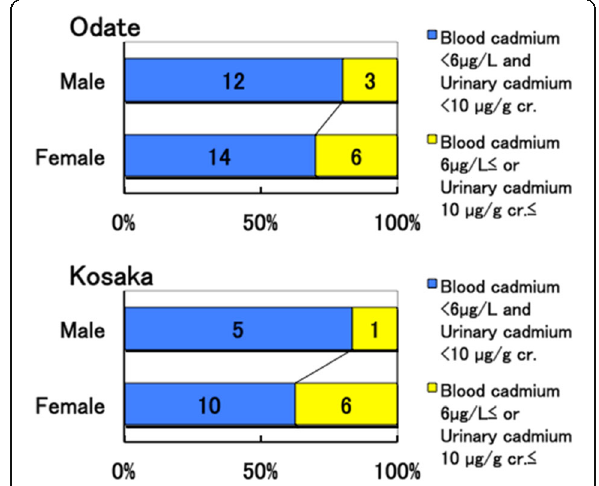
Fig. 1 Distribution of urinary ß 2 -microglobulin ( β 2MG) levels among 35 and 22 subjects in Akita Rosai Hospital in Odate city (Odate) and Kosaka Clinic in Kosaka town (Kosaka), respectively. The actual numbers are presented in the bars